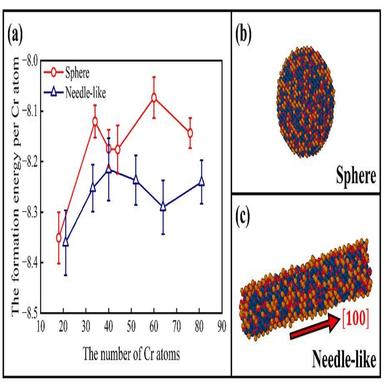
(a) The formation energy of sphere and needle-like Cr-rich oxides (FeCr2O4). The schematic diagram of the sphere and needle-like Cr-rich oxides are shown in (b) and (c), respectively.